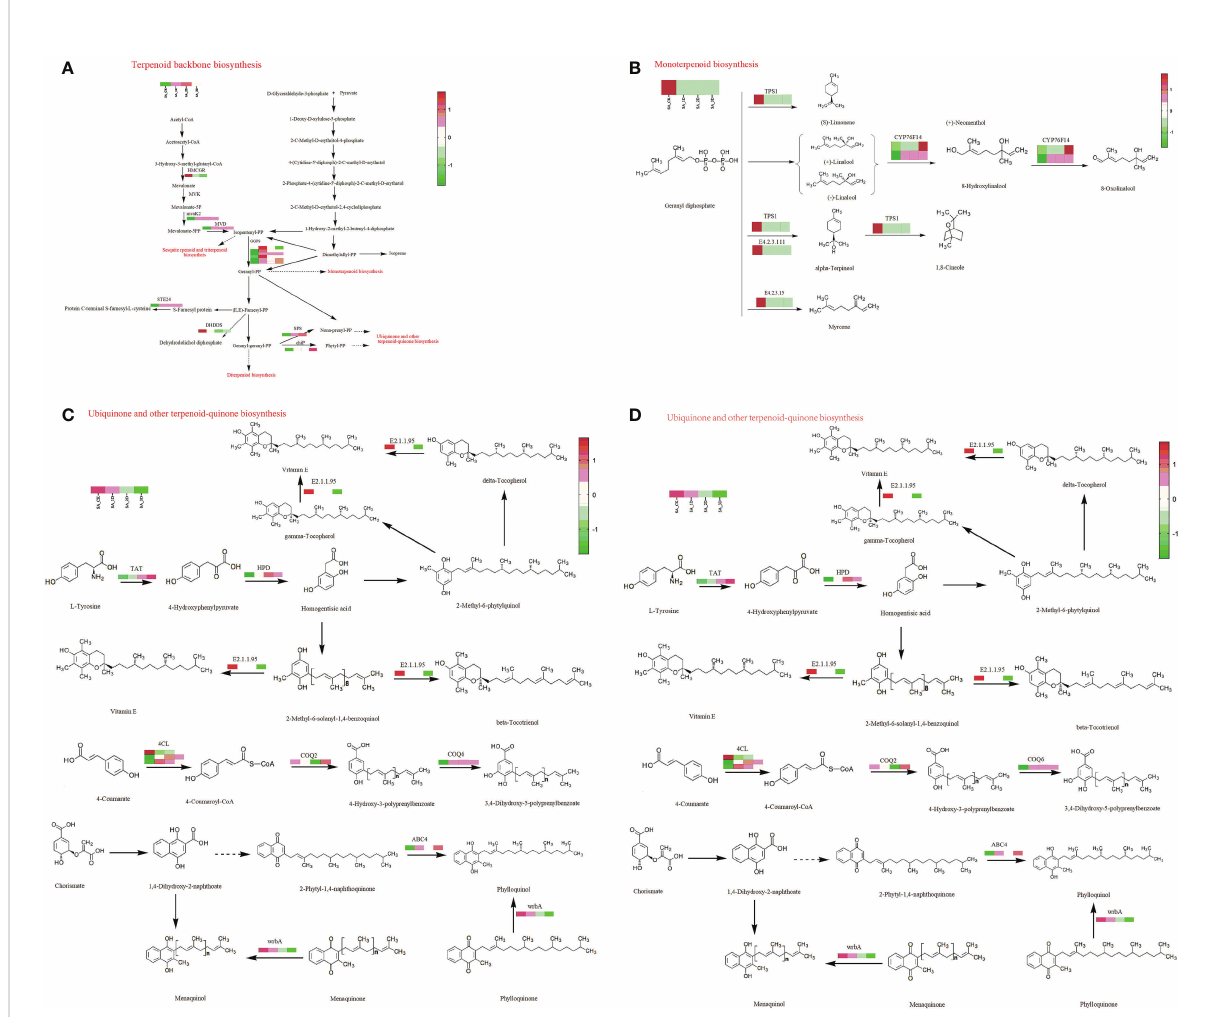
FIGURE 5 DEGs involved in Terpenoid Biosynthesis Pathways; (A) The DEGs enriched in the terpenoid backbone synthesis pathway; (B) The DEGs enriched in the monoterpene synthesis pathway; (C) The DEGs enriched in the diterpene synthesis pathway; (D) The DEGs enriched in the ubiquinone and other terpenoid quinone synthesis